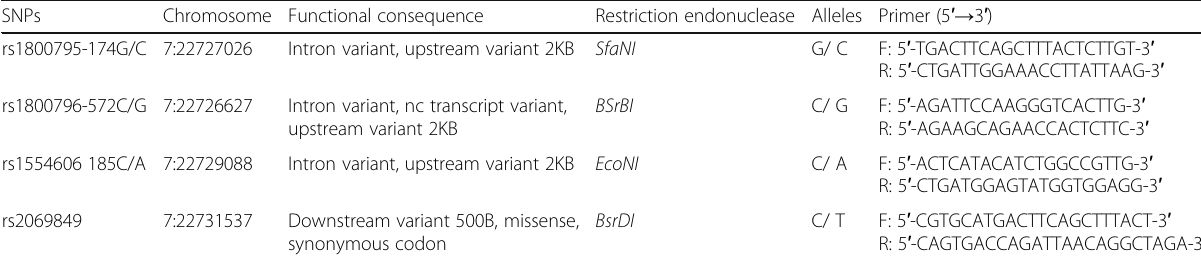
Table 1 Description of 4 SNPs within IL-6 gene and the primers designed